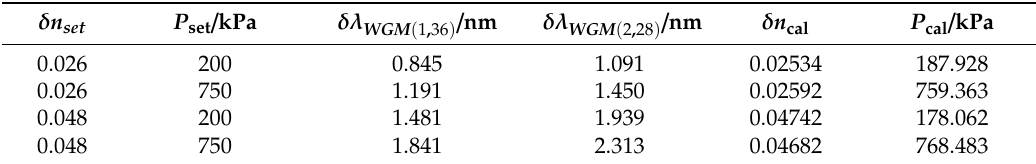
Table 1. Dual sensing of RI and Pressure Based on the MDR